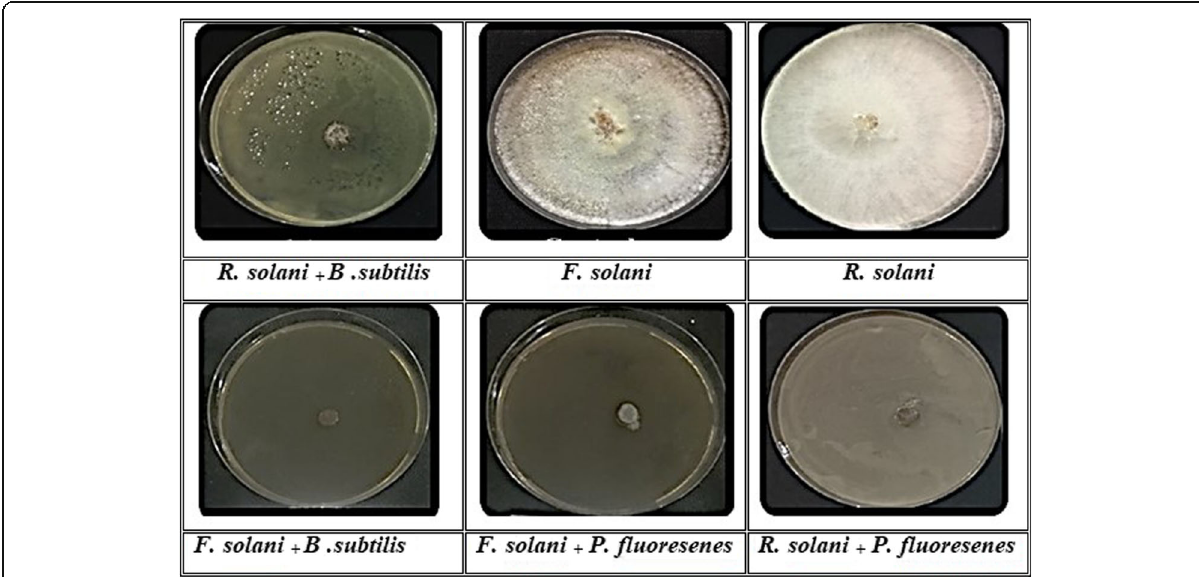
Fig. 6 Effect of P. fluorescens and B. subtilis on the inhibition of the radial growth of R. solani and F. solani